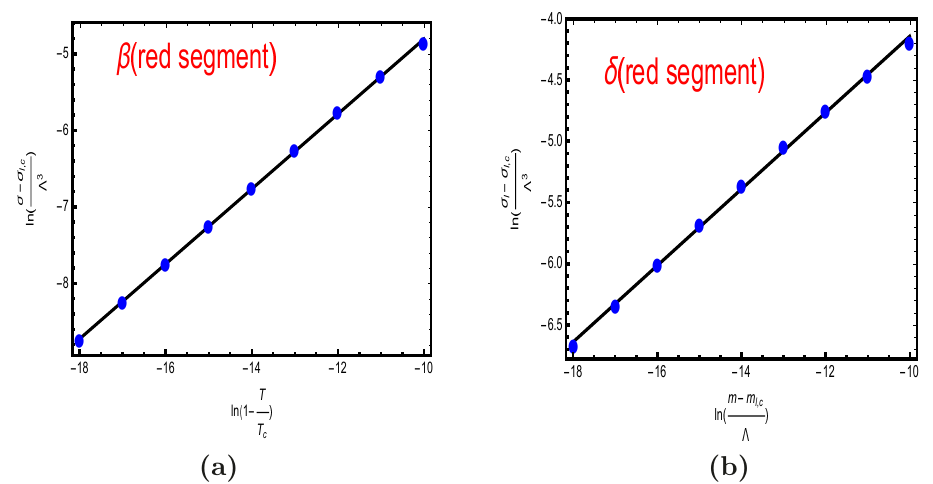
Figure 9 . Temperature and quark mass dependence of chiral condensate near the critical point T l,c 1 = 0 . 2063571 . . . GeV , m l,c 1 = 0 , m s,c 1 = 0 . 300 . . . GeV , σ l , c1 = 0 , σ s , c1 = 0 . 010 GeV 3 , which locates at the red segment of the chiral critical line. Panel.(a) gives ln( σ l − σ l,c 1 ) = ln( σ l ) as a Λ 3 Λ function of ln( t ) ln( T l,c 1 − T ), with fixed quark mass m l = m l,c 1 = 0 , m s = m s,c 1 = 0 . 300 . . . GeV. T l,c 1 ≡ The blue dots are model calculation and the black solid straight line are linear fitting of the dots, which has the form y = 0 . 093 + 0 . 490 x . Panel.(b) gives ln( σ l − σ l,c 1 ) = ln( σ l ) as a function of Λ 3 Λ ) = ln( m l ). The blue dots are model calculation and the black solid straight line are ln( m l − m l,c 1 Λ Λ linear fitting of the dots, which has the form y = 1 . 022 + 0 . 312 x . − and δ calculation respectively. It gives β = 0 . 339 , γ